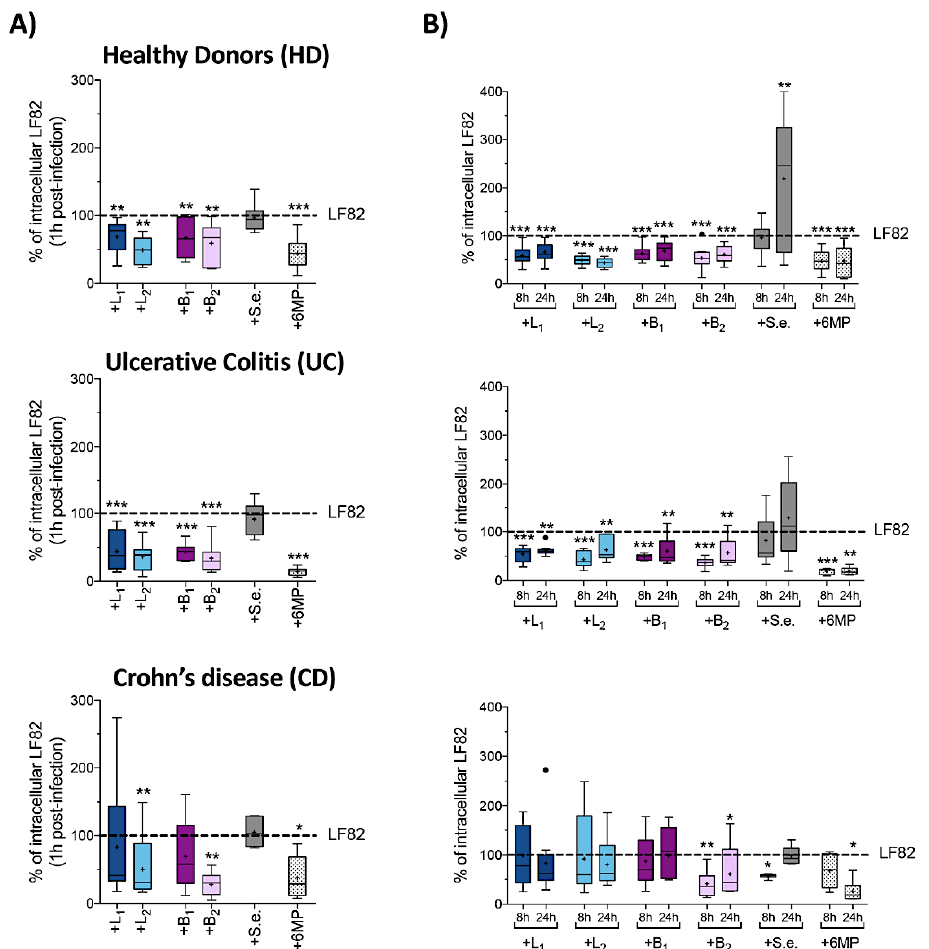
Figure 4. E ff ects of probiotic strains on phagocytosis and intracellular survival of AIEC-LF82 within human monocyte-derived dendritic cells (MoDC). Percentage of internalized AIEC-LF82 cells within MoDC derived from HD, UC or CD patients after 1 h ( A ), 8 and 24 h of infection. ( B ) MoDC were infected with LF82 alone (taken as 100%) or in the presence of Lactobacillus strains ( + L 1 , + L 2 ) or Bifidobacterium strains ( + B 1 , + B 2 ) or S. epidermidis ATCC-155 ( + S.e.), at 1:1 ratio or in the presence of 6MP (2 µ g / mL). Each experiment was performed in triplicate and data are represented as described in Figure 1. Statistical significance for each condition compared to MoDC infected with LF82 alone was reported (* p < 0.05, ** p < 0.01, *** p <